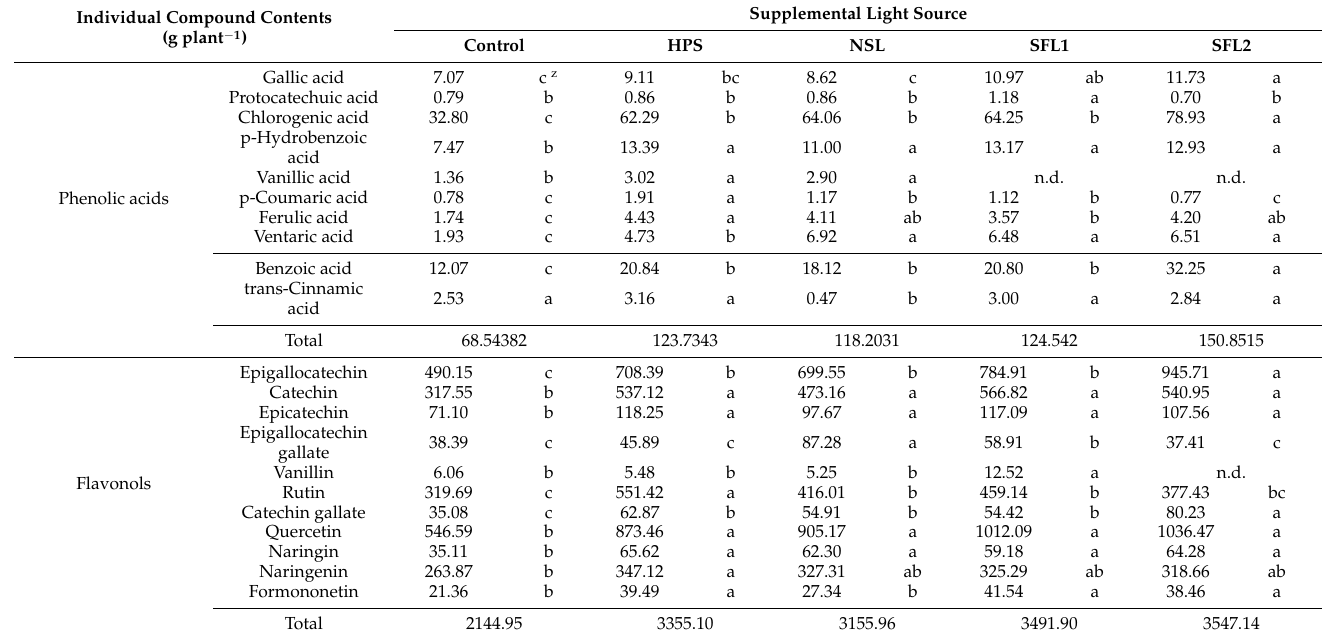
Table 5. Individual phenolic acid and flavonol contents of the cherry tomato fruits grown with different SL sources after 7 weeks of treatment. Different letters indicate significant difference at p < 0.05 ( n =